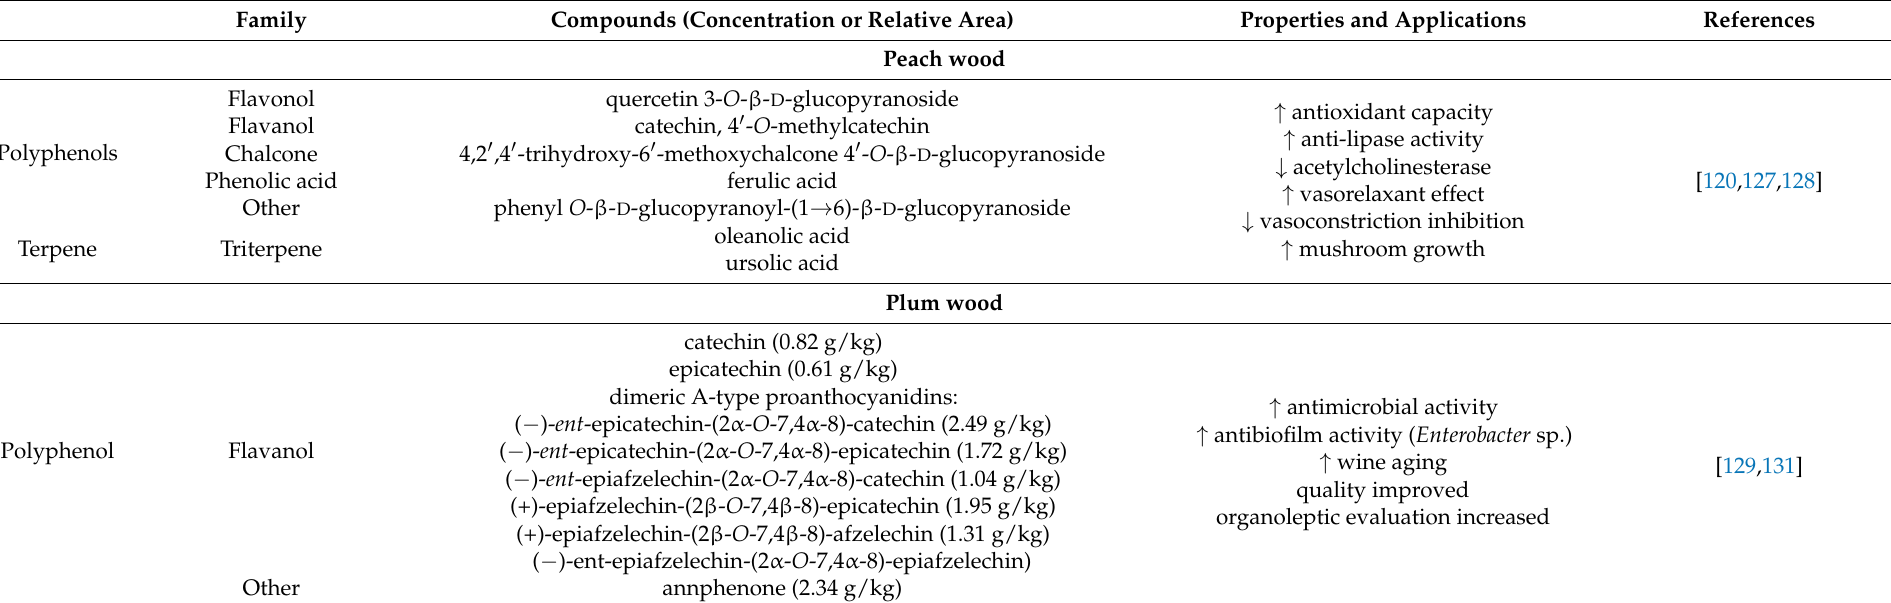
Table 5. Chemical composition, quantitation, major bioactivities, and applications of wood from stone fruit trees. * ↑ : Increase; ↓ : Decrease. Chemical structures by families are shown in Figure